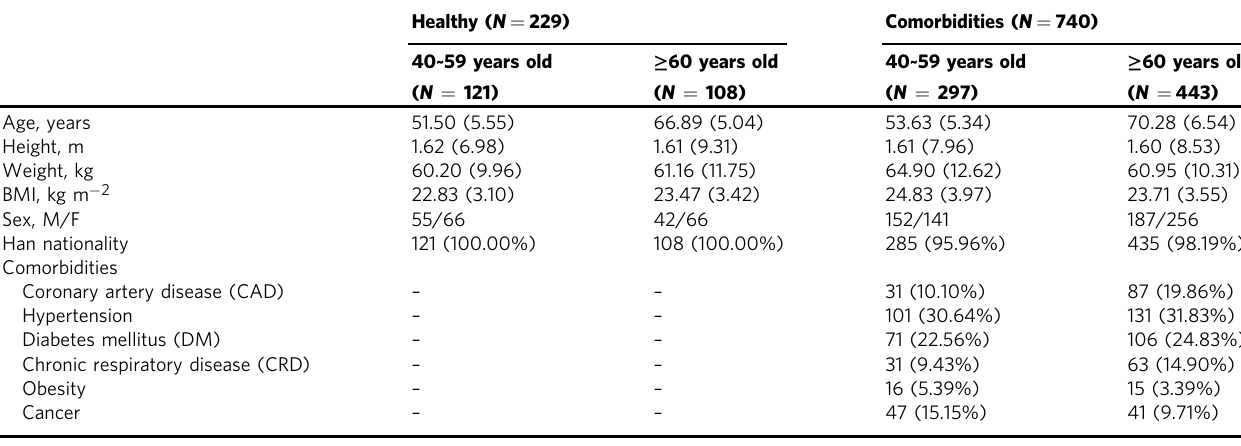
Table 1 Demographic and clinical characteristics of the study participants.